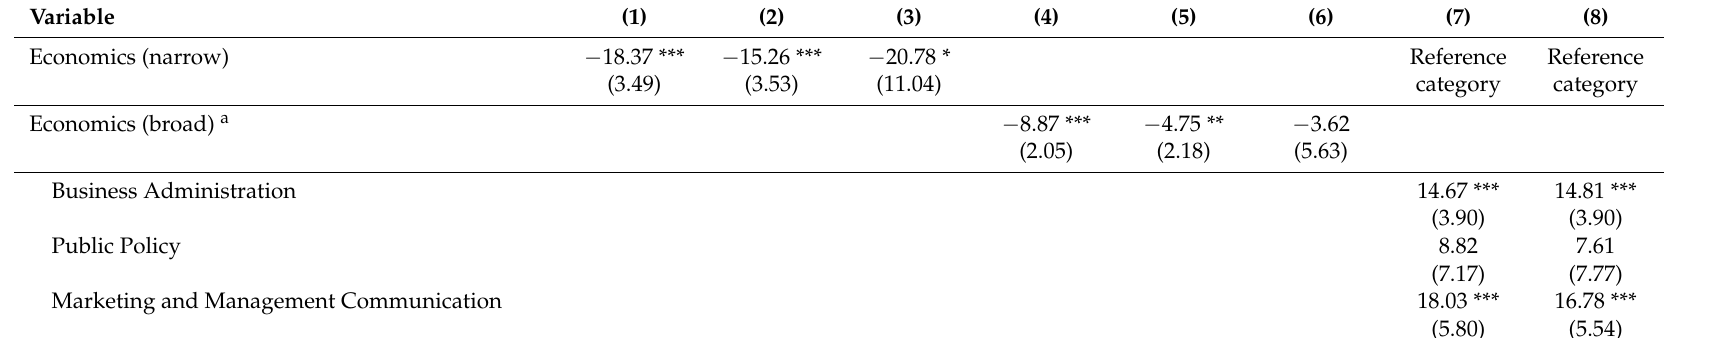
Table 2. Ordinary least squares regressions for contributions to others in the social dilemma game